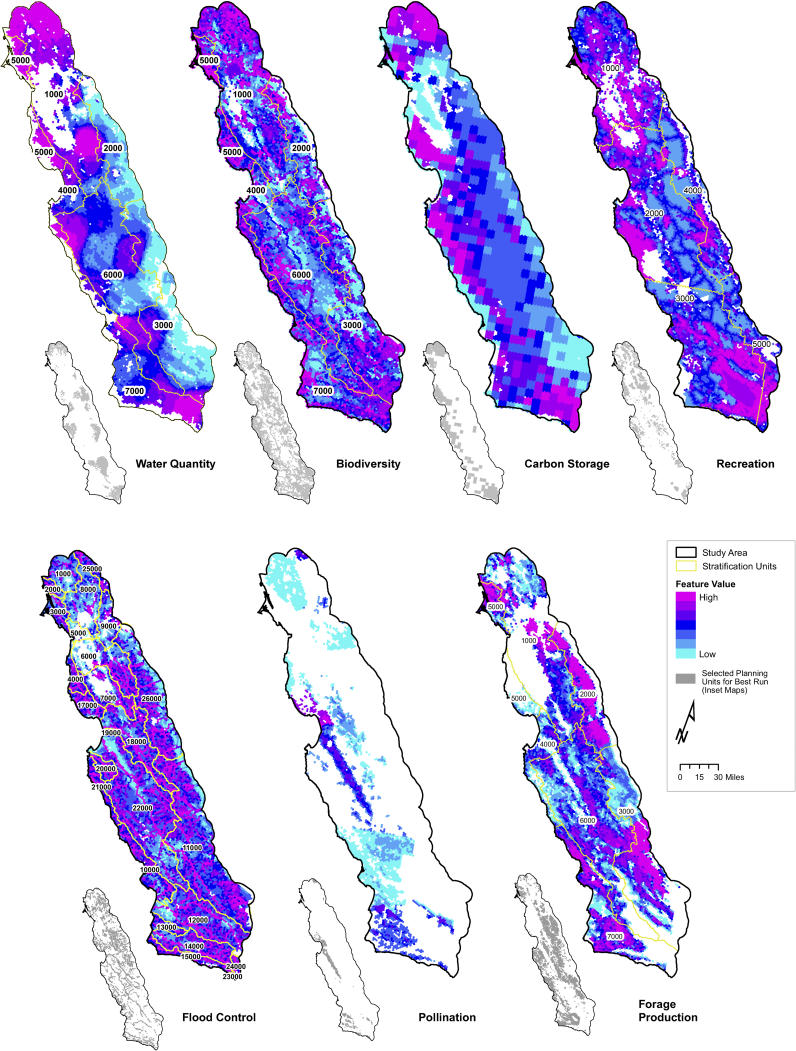
Spatial Analysis of Biodiversity and the Chosen Ecosystem ServicesThe seven benefit functions (feature values) are displayed in color with the accompanying best networks of selected planning units in gray insets. Feature values range from 0 (or locked out; white), to low (light blue), moderate (dark blue), and high (purple). The boundary indicates the ecoregion plus the 10-km buffer. Yellow lines indicate stratification units, within which individual targets were pursued. Numbers in the thousands (×000) are stratification unit labels. Not shown are planning-unit–specific constraints and stratification-unit–specific targets.